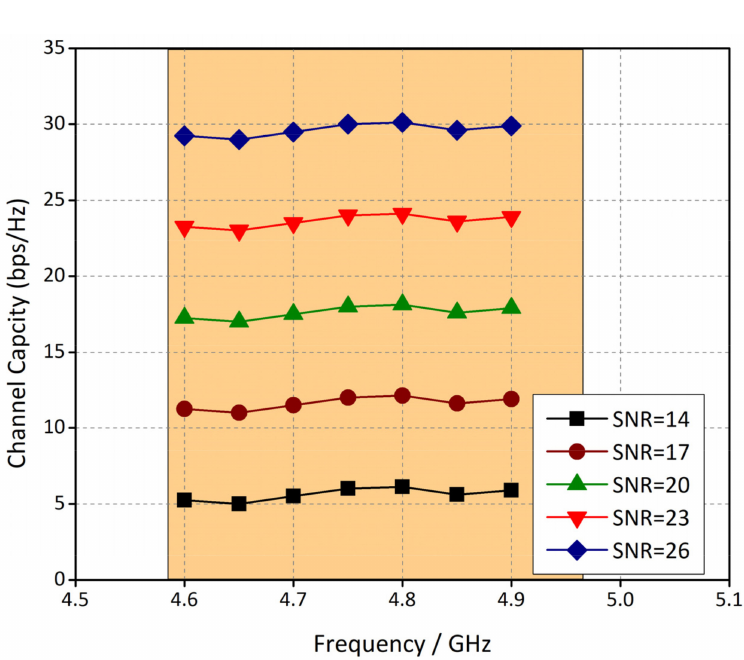
Figure 10. Calculated channel capacity at different